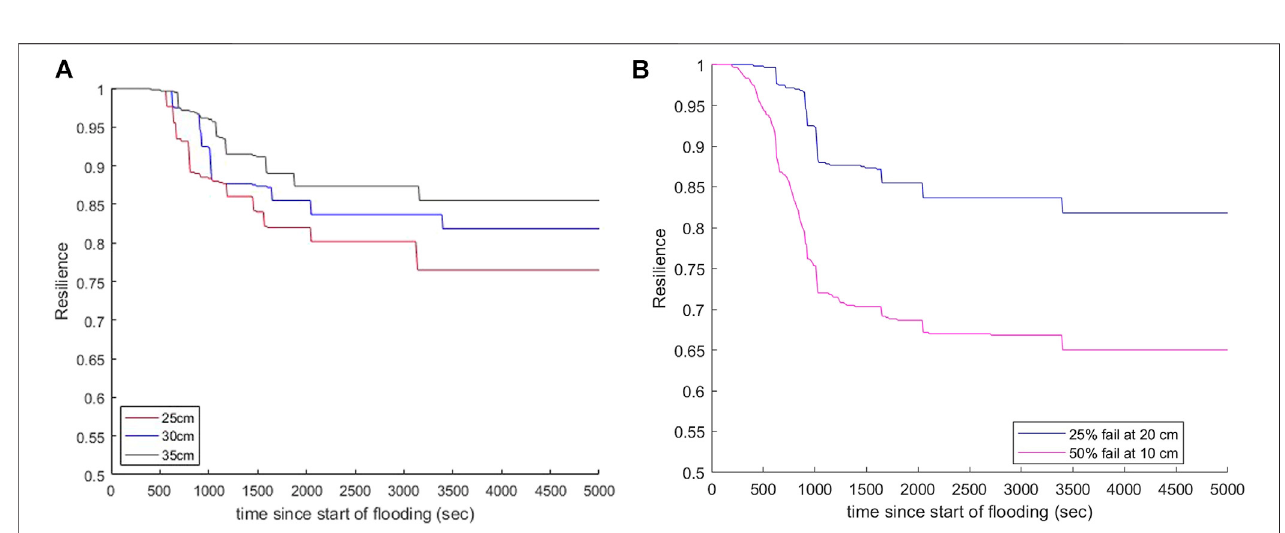
FIGURE 7 | Network Flood Resilience for changing (A) critical outdoor water depth; (B) indoor failure criteria.